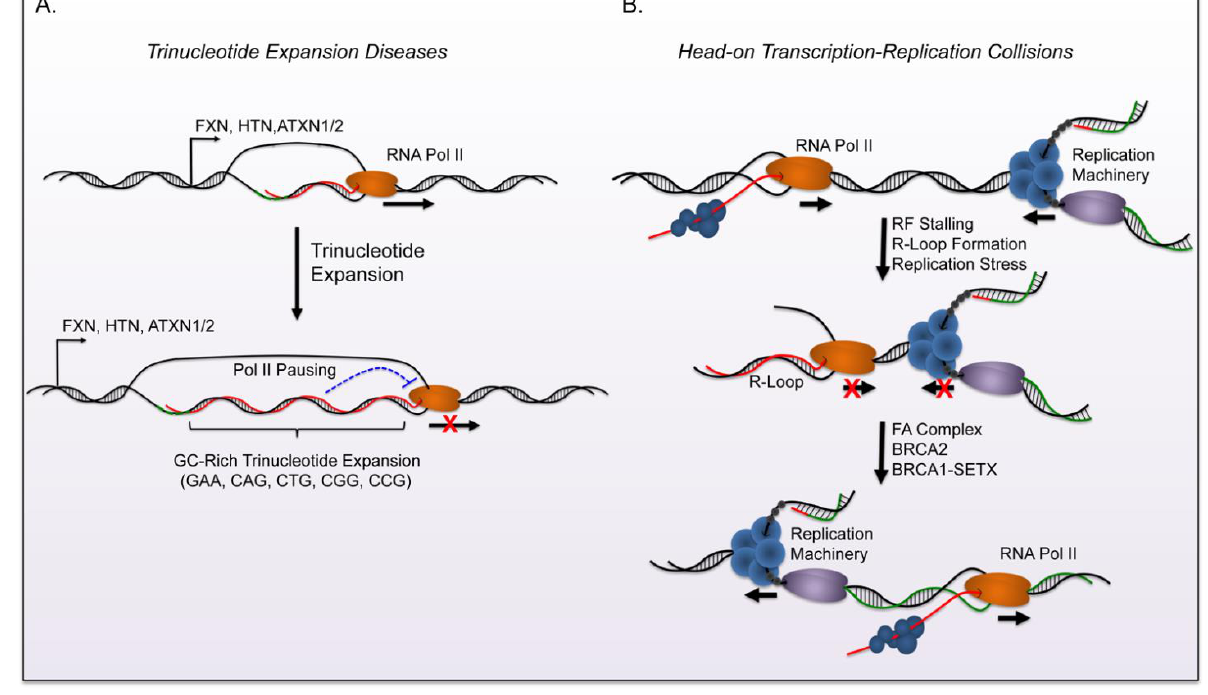
FIGURE 2: Biological consequences of R-loop formation. Formation of R-loops can result in defects in transcription and genomic instability. (A) Evidence indicates that R-loop formation contributes to trinucleotide expansion related diseases. The expansion of GC rich sequence in the gene body creates conditions that are favorable for R-loops and can subsequently cause reduced expression of specific genes (FXN, HTN, ATXN1/2). These diseases typically result in neurodegenerative disorders and ataxia. (B) Head-on collisions between the replication fork and transcription bubble create favorable conditions for R-loop formation. The FA complex, along with BRCA1, and other factors promote bypass and resolve R-loops during these collisions in order to complete replication and maintain genome stability. Mutation in FA complex subunits increase DNA damage associated with collisions and this damage is associated with cancer